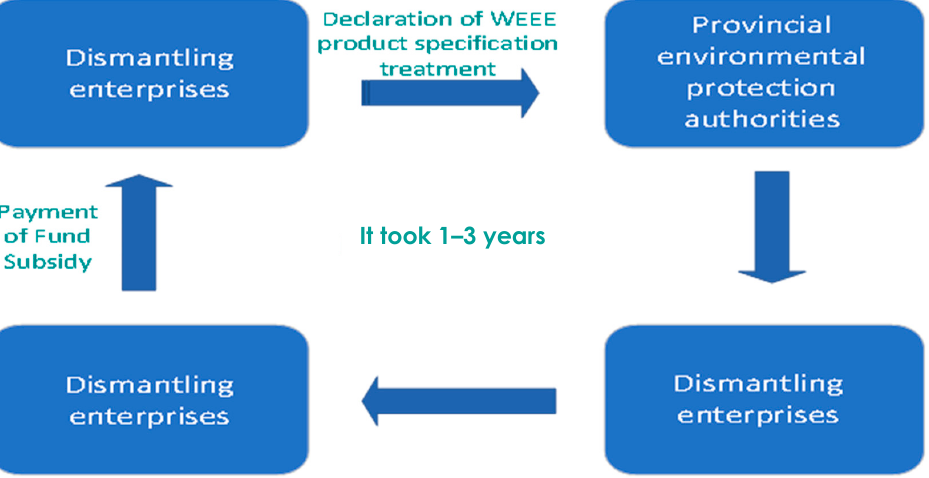
Figure 10. Schematic diagram of China’s EEE dismantling subsidy application process.